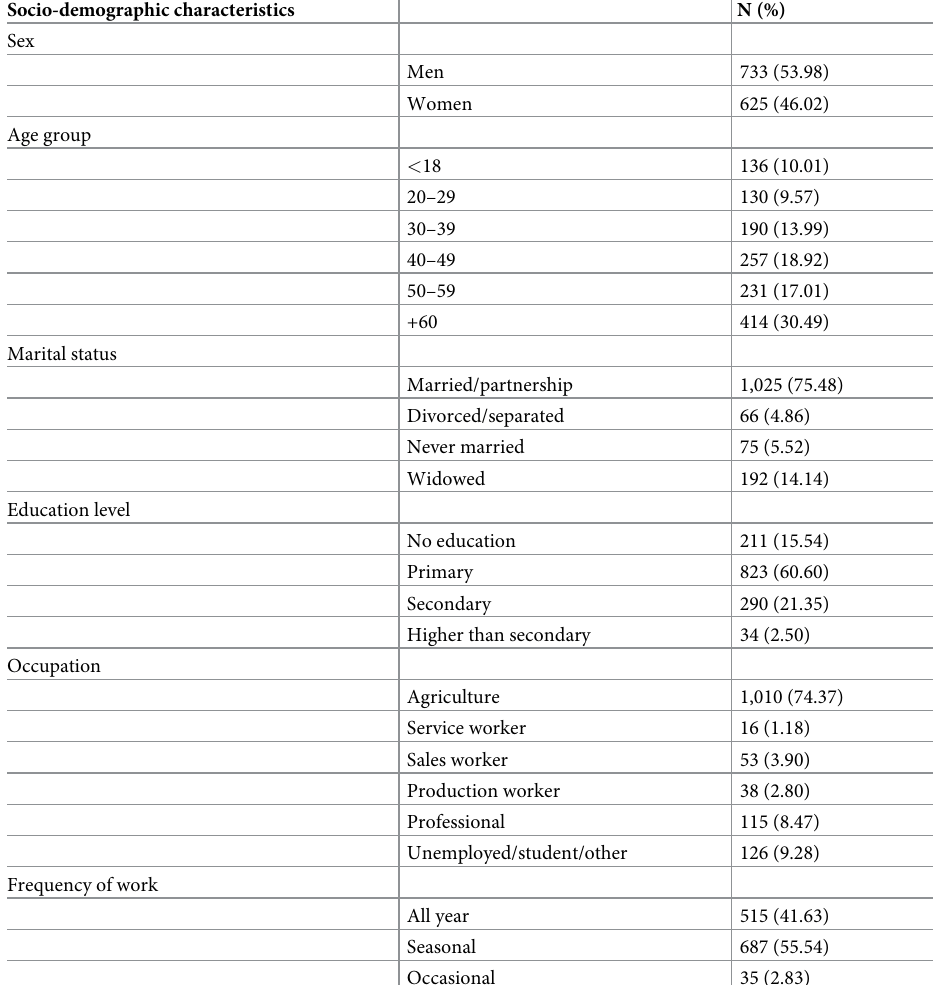
Table 1. Sociodemographic characteristics of study participants (n = 1,358). Socio-demographic